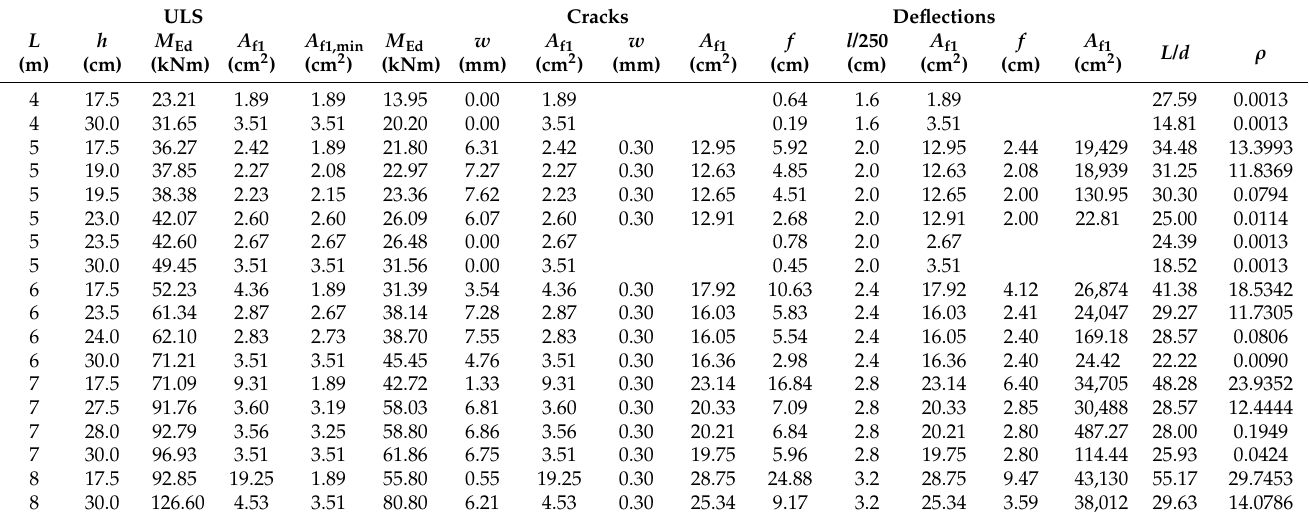
Table 8. Results of parametric analysis for FRP-reinforced